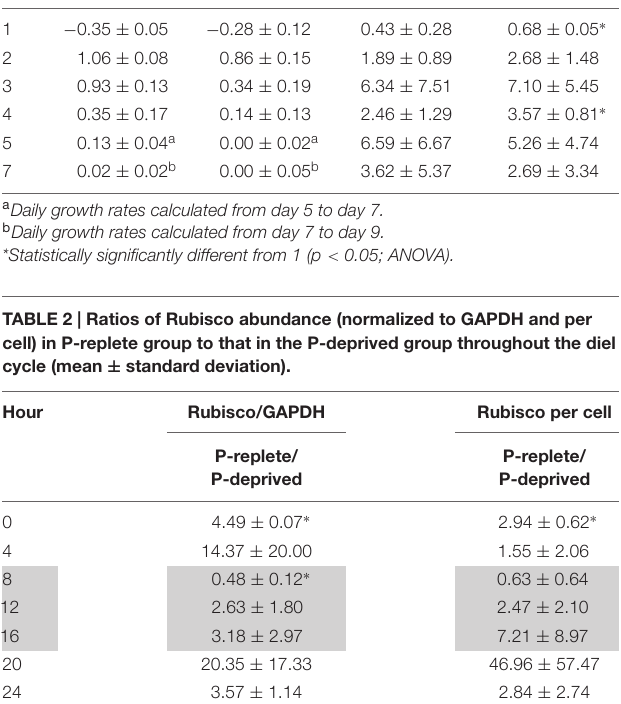
Rubisco GAPDH per cell